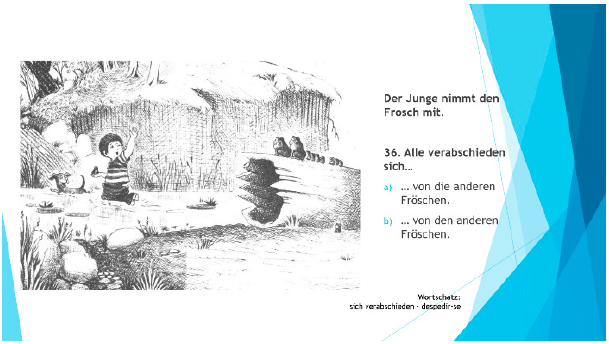
Figure A41. Posttest: Binary-choice recognition task.